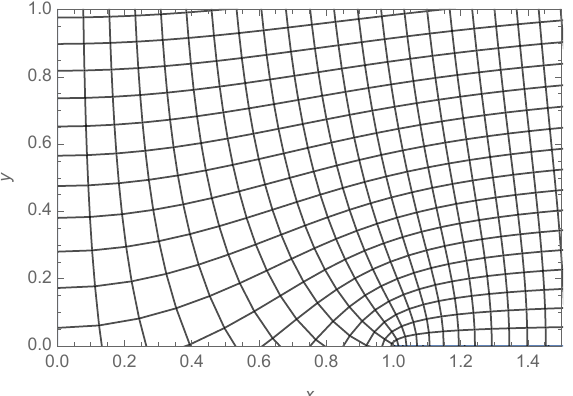
Figure 1 . 2 d illustration of how flat space-time can support ‘relative geometry’ relative to a vacuum reference frame. Boundary conditions around geometrical objects (apertures, edges etc.) may cause local coordinate redefinitions of the actual flat frame. The mesh delineates a (2d cut-out of) flat space-time that causes hyperbolic geodesics in the reference frame. An illustration of those geodesics can be found in figure 3. Further adjustments need to be made along the slit opening ( x < 1 , y = 0) for smoothness and edge | |